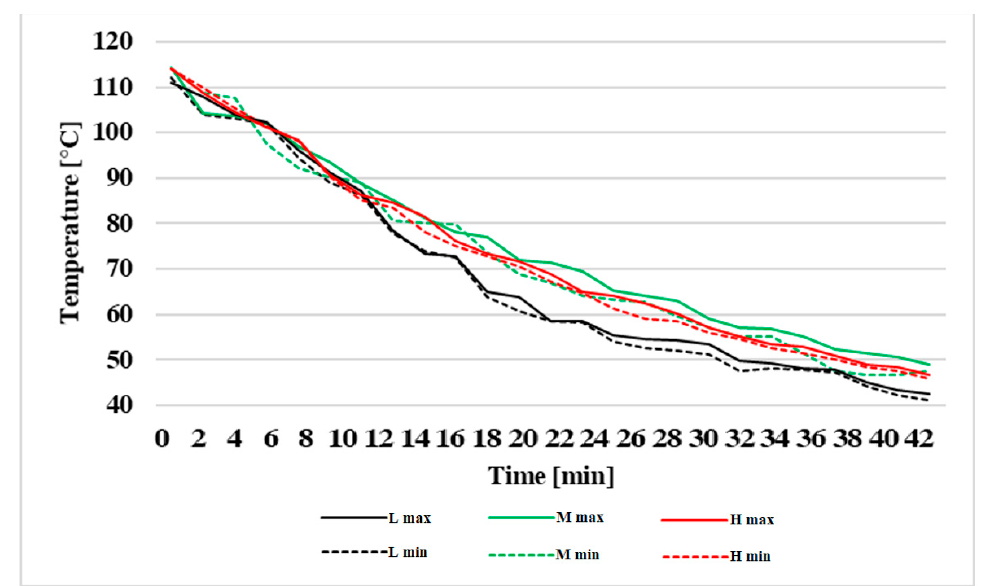
Figure 14. Brake discs’ temperature in the section of contact with charge.